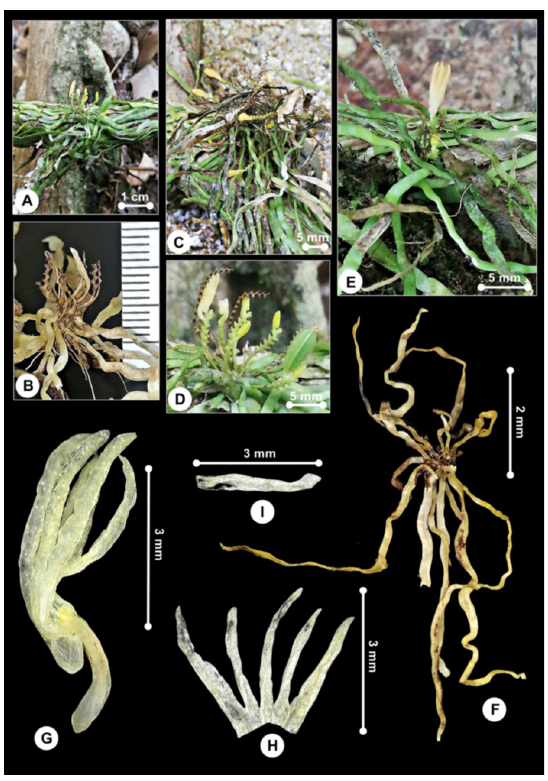
Fig 13. Taeniophyllum rugulosum . A. Plant growing on a fallen twig of Neonauclea sp. (Rubiaceae) tree in a riverine forest. B, C, D, E. Inflorescence from lateral and front view. F. Plant’s top view showing wrinkled roots (spirit- preserved). G. Flower’s lateral view (spirit-preserved). H. Sepals and petals (spirit-preserved). I. Labellum’s lateral view